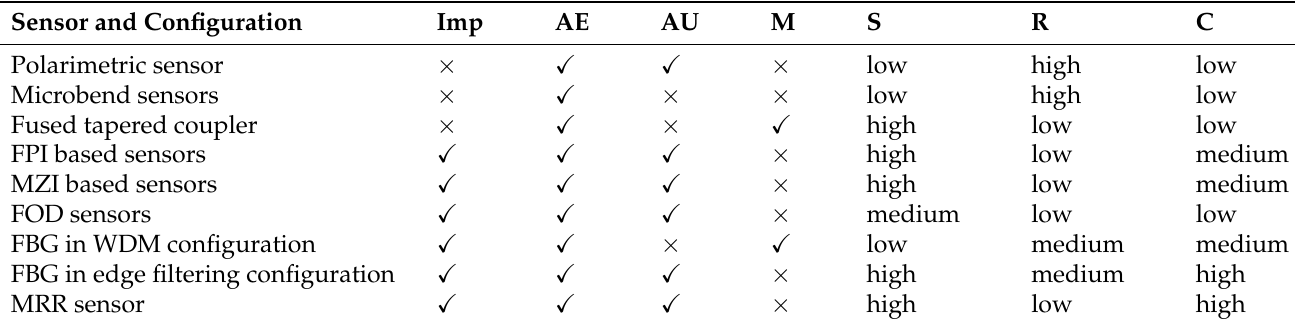
Table 1. Summary of different sensor configurations, their applicability, and key